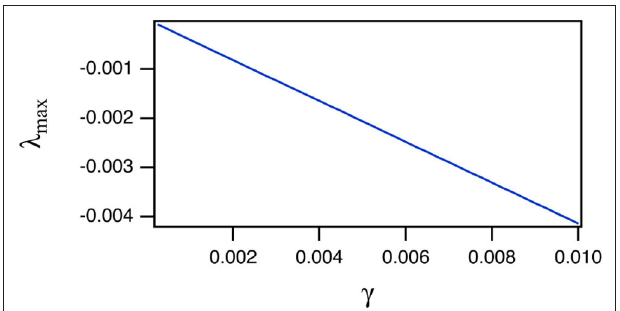
FIGURE 3 | Largest Lyapunov exponent λ max for the spiking reservoir when driven by the Sprott A system as the damping constant γ varies. The largest Lyapunov exponents when driven by the other systems were almost identical, so only the result from A is shown.